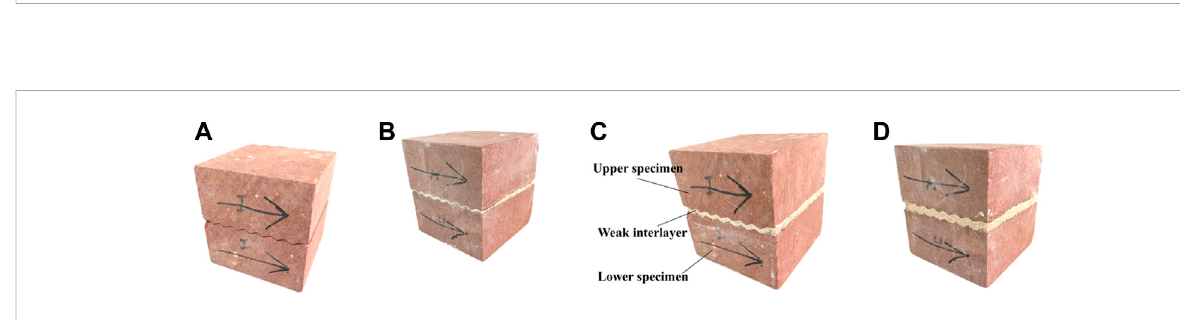
FIGURE 5 Sample of rock joint with different fi lling degrees: (A) k = 0; (B) k = 0.5; (C) k = 1.0; (D) k =